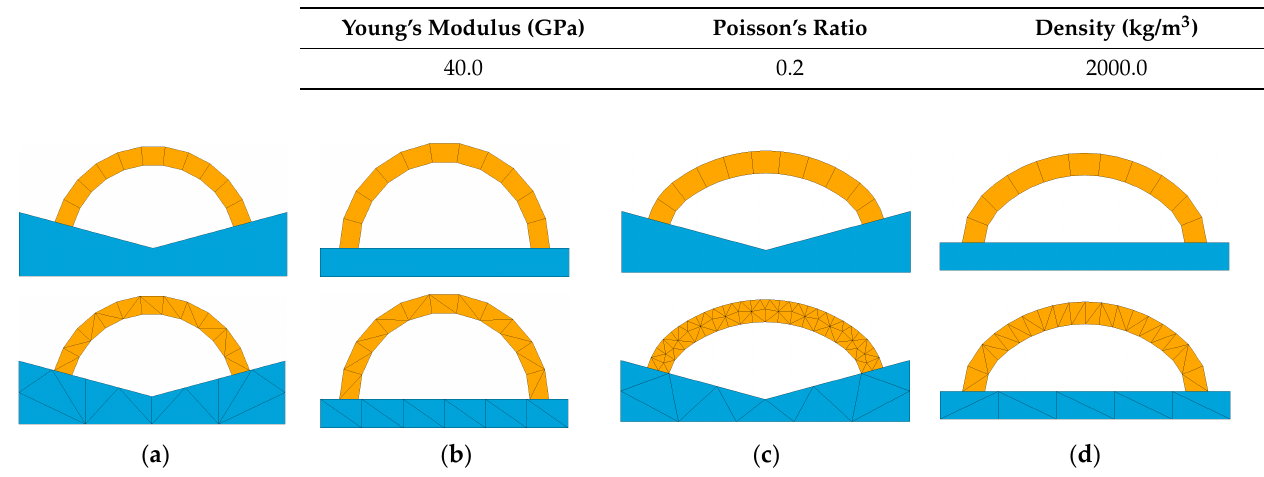
Figure 4. Mesh configurations: ( a ) circular arch with β = 150° ( N = 36); ( b ) circular arch with β = 180° ( N = 34); ( c ) basket- handle arch with β = 150° ( N = 106); ( d ) basket-handle arch with β = 180° ( N = 46).